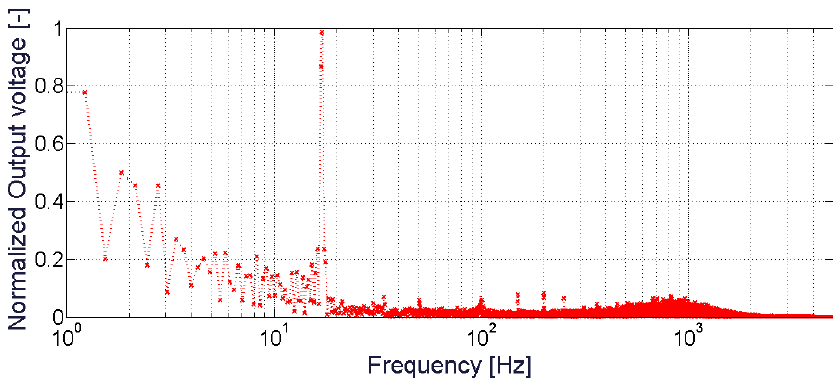
Figure 8. Fast Fourier Transform (FFT) of the BC output voltage in the presence of sinusoidal mechanical vibration, at 17 Hz. Data have been normalized to the maximum value of the spectrum.